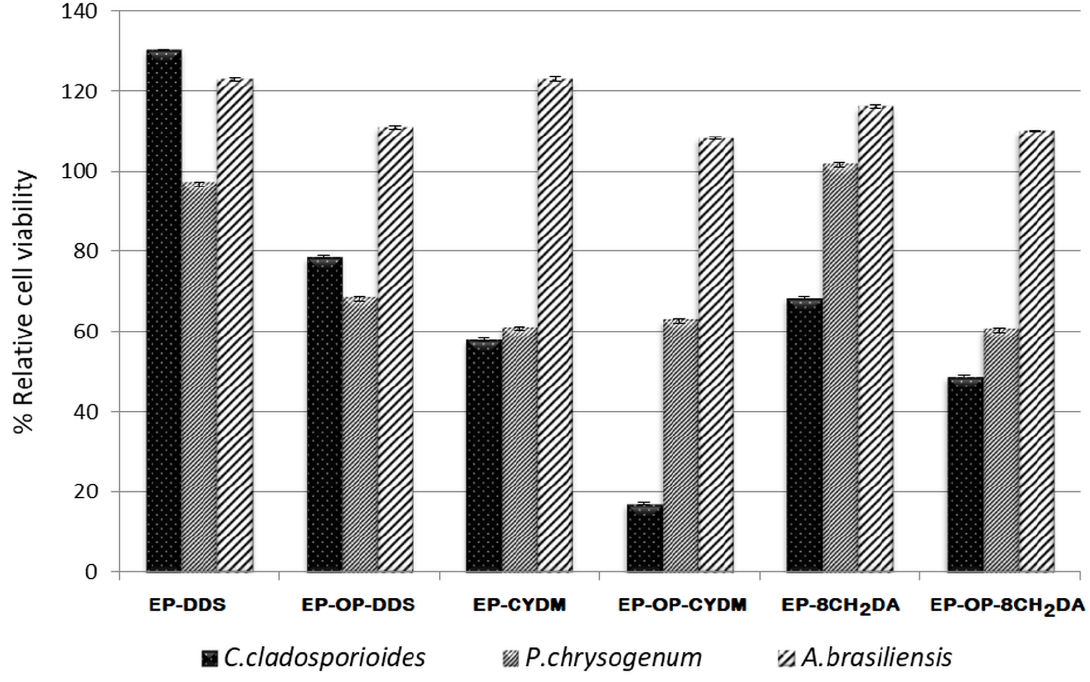
Figure 13. Fungistatic efficacy of the S–IPNs and control samples against the reference strains .